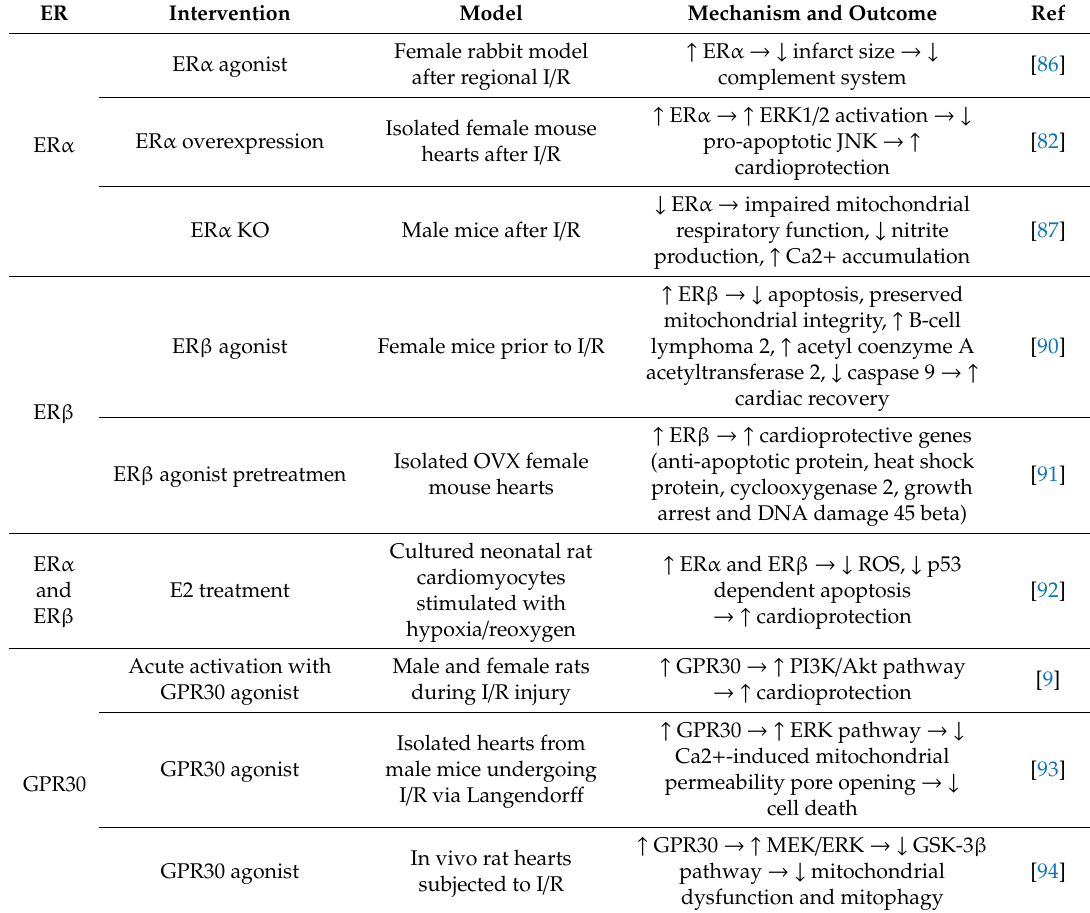
Table 4. Role of estrogen receptors in ischemia / reperfusion